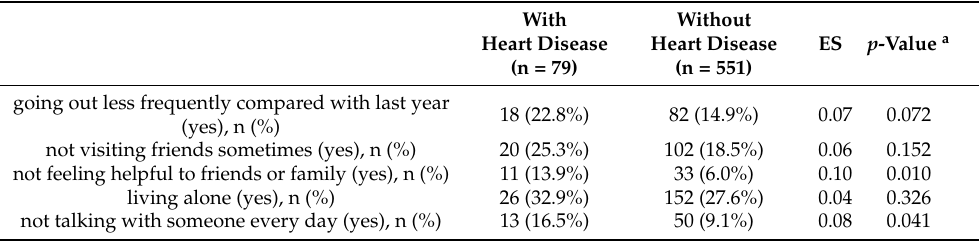
Table 3. Association Between Heart Disease and the Five Elements of Social Frailty.